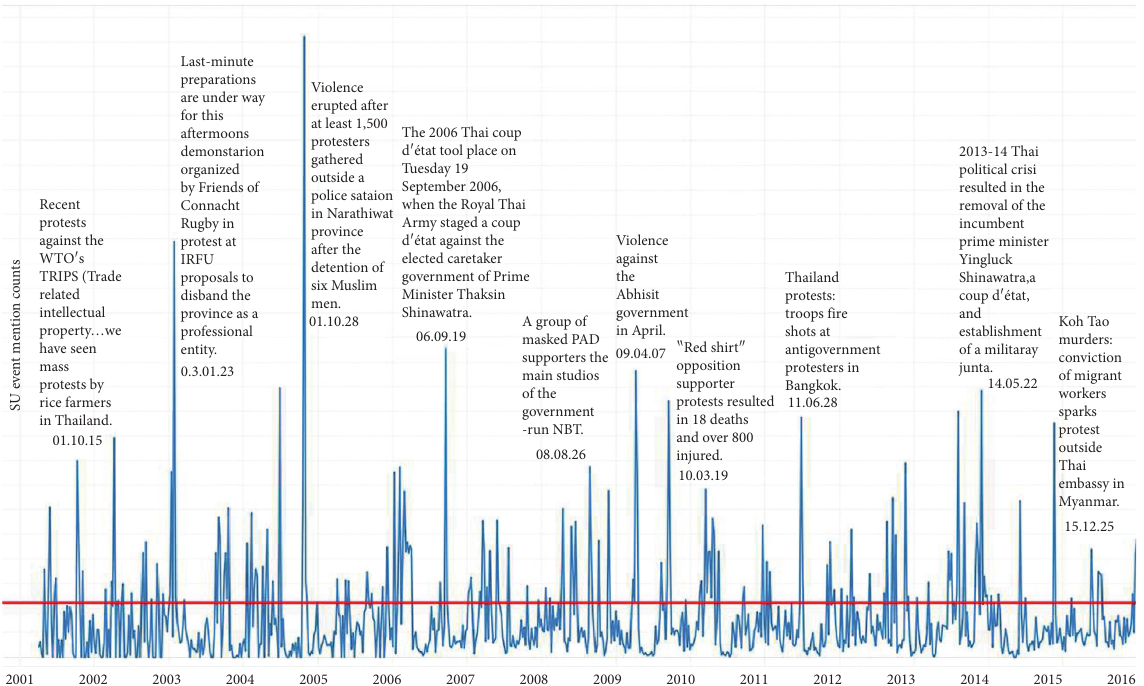
Figure 4: Normalized SU event mention counts of Thailand with annotations for top ten stretches above θ (red